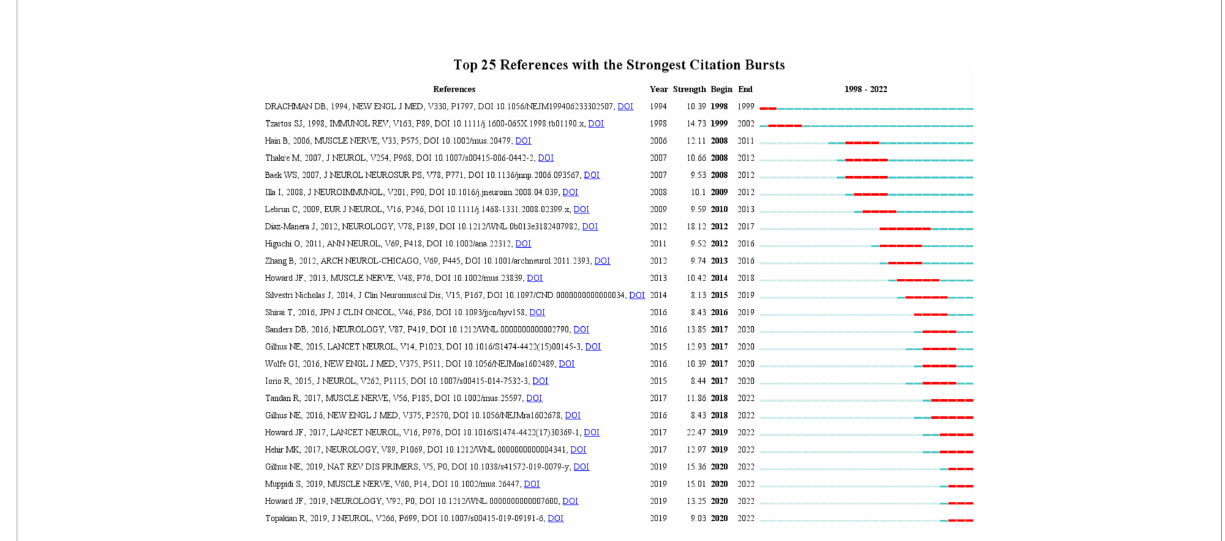
FIGURE 8 The top 25 references with the strongest citation bursts. The red segment represents the begin and end year of the burst